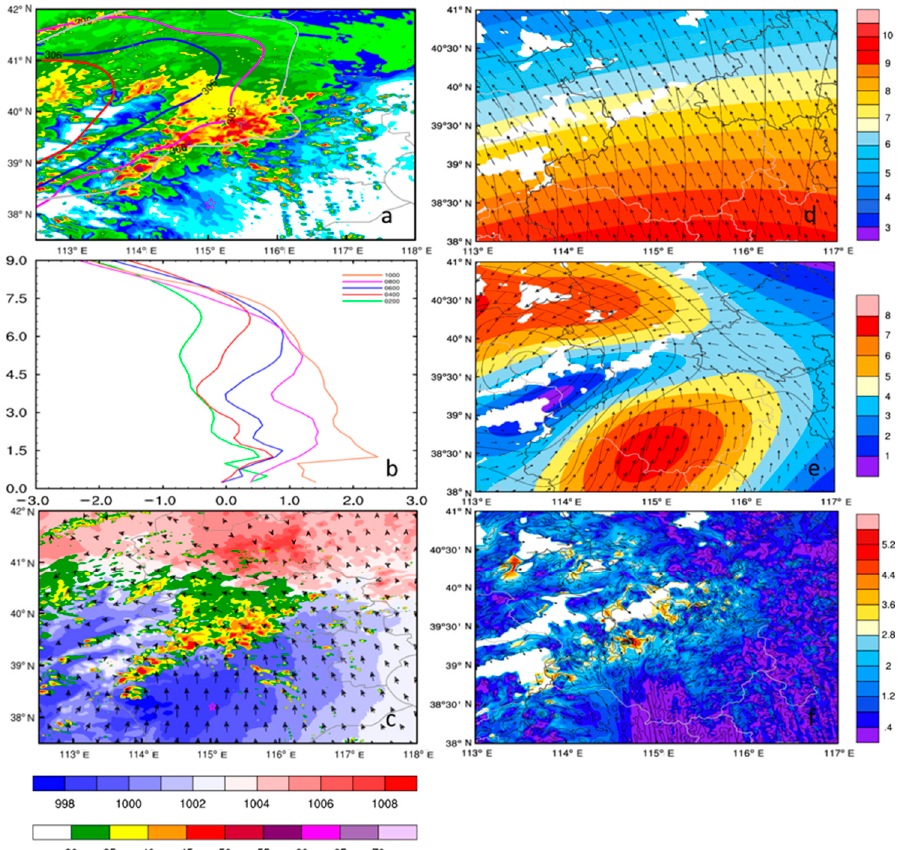
Figure 8. ( a ) Simulated composite radar reflectivity (shaded, units: dBZ) at the initiation time of MCS-C. The red, blue, and magenta lines represent the 306 (units:10 gpm) feature line of Hetao vortex at 700 hPa at 0400, 0600, and 0800 UTC, respectively. ( b ) Area-averaged vertical profile of the 306 feature lines (units: 10 gpm) of Hetao vortex. ( c ) Simulated composite radar reflectivity (shaded, units: ≥ 35 dBZ), the sea level pressure (red and blue shading, units: Pa), and the 10-m wind field (arrows) at the initiation time of MCS-C. The initiation location of the first convective cell over the plains is marked with the magenta pentagram. ( d – f ) The large-scale, meso-scale, and small-scale component of wind field at the initiation time MCS-C, which were extracted by Barens’ (1973) low-pass, band-pass, and high-pass filtering methods, respectively. All of them include the wind speed field (shaded, units: m s − 1 ), the vorticity field (contours, units: s − 1 ), and the wind field (vector arrows, units: m s − 1 ).